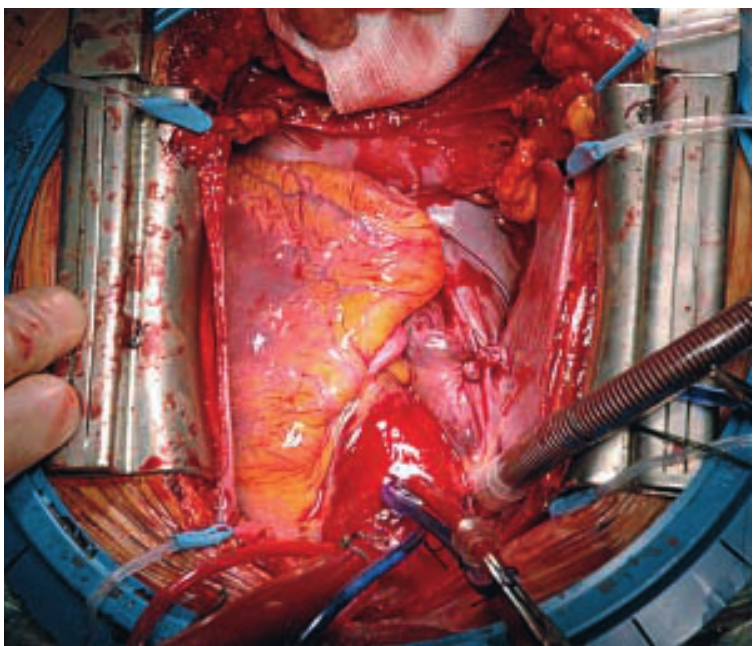
Operative view showing completed hepato-atrial